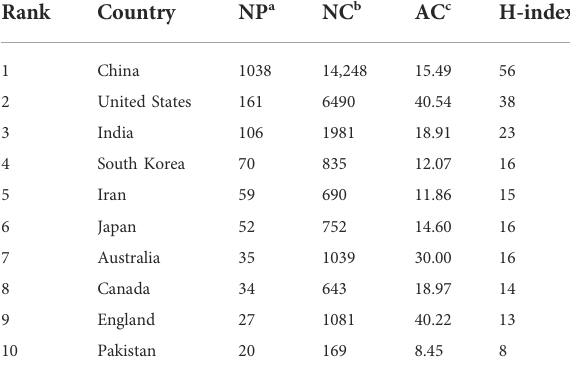
TABLE 1 Topmost 10 productive countries/regions in the fi eld of herbal medicine to control